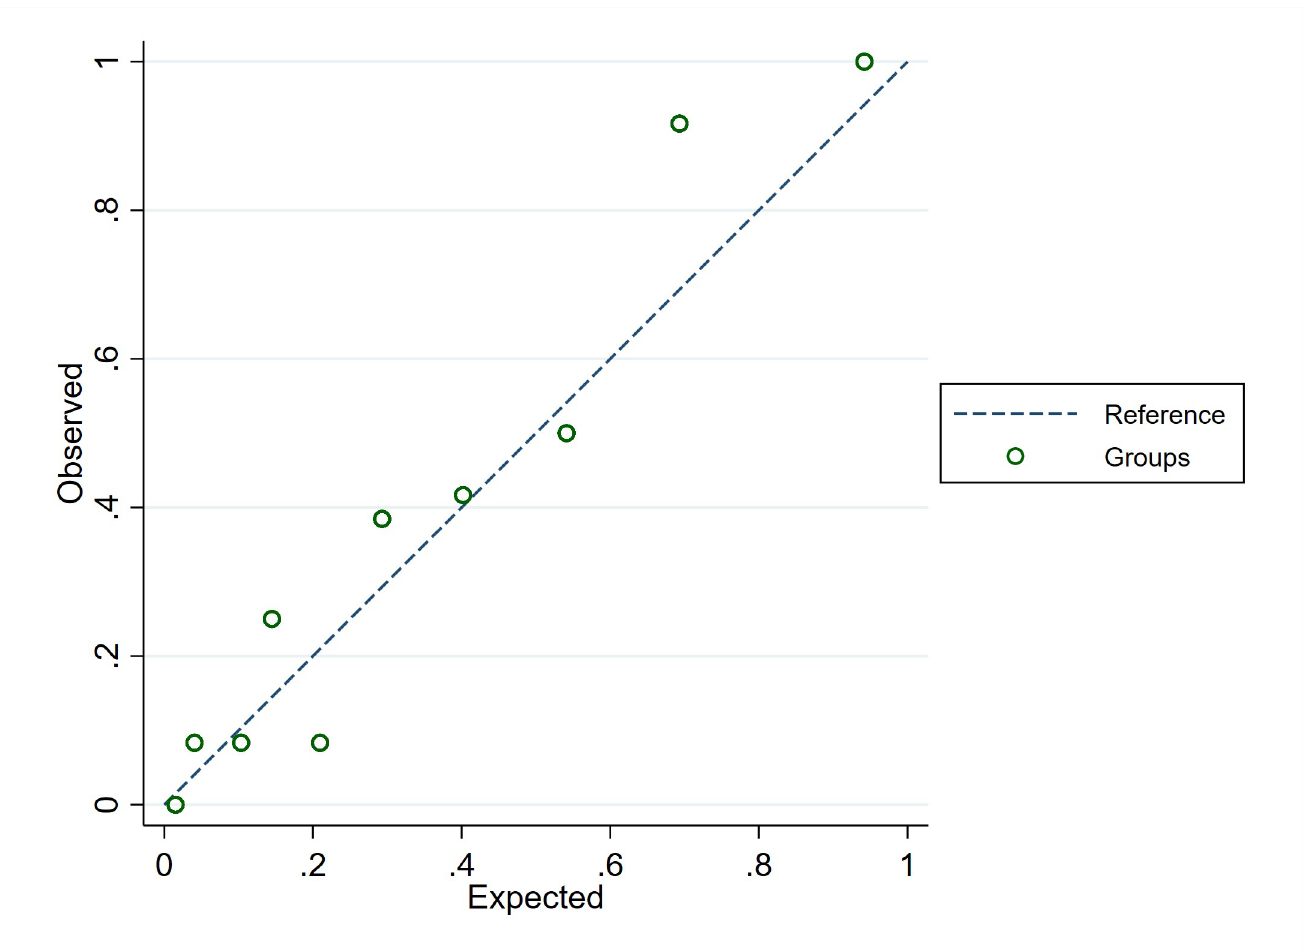
Fig 2. Calibration plot of the multivariable prediction model for 28-day mortality of critically ill COVID-19 patients admitted to ICU.